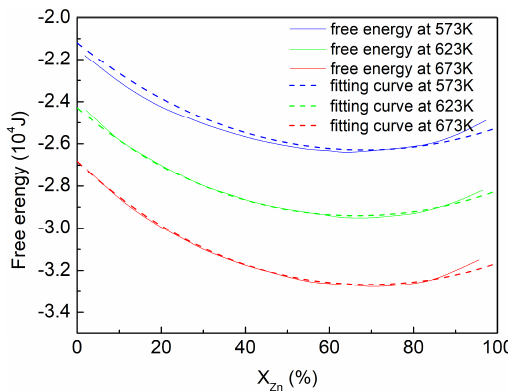
Figure 1. The free energy-component curve of ZK60 Mg alloy obtained by the software Thermo-Calc at 573 K, 623 K and 673 K, and their fitting curves.